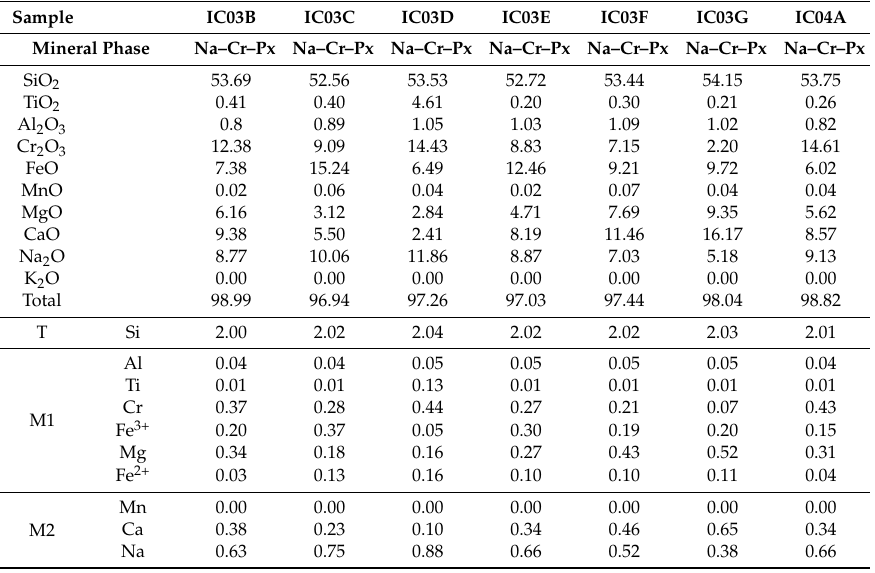
Table 1. Representative microprobe analyses and structural formulae of Na–Cr-rich pyroxenes from this study. Sample Mineral Phase